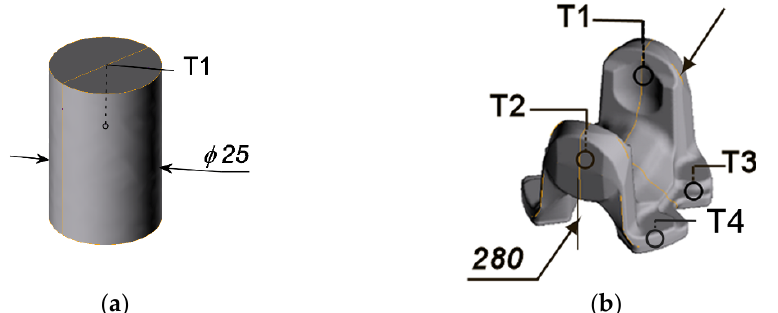
Figure 1. Geometry of samples used in the study: ( a , b ) samples used for validation of the estimated heat transfer coefficient, where T1 ÷ T4 are designations of thermocouples.